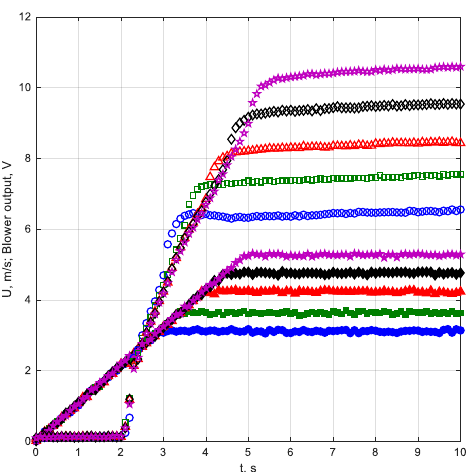
Figure 21. Mean wind velocity (empty symbols) and the blower output voltage (filled symbols) during the initial stages of experimental runs.